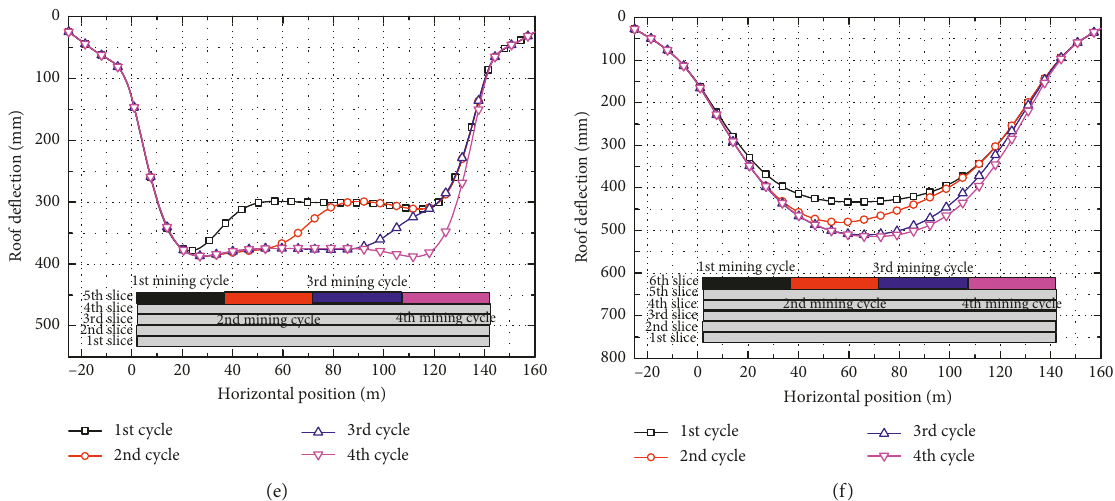
Figure 7: Deflection curves of the roof in different mining cycles of each slice: (a) first slice; (b) second slice; (c) third slice; (d) fourth slice; (e) fifth slice; (f) sixth slice.